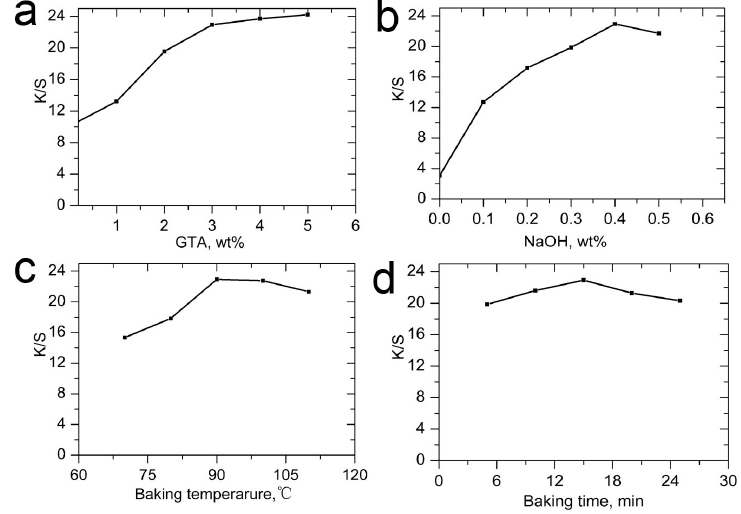
Figure 2. Effects of ( a ) GTA concentration; ( b ) NaOH concentration; ( c ) baking temperature; and ( d ) baking time on the K / S values of magenta ink.